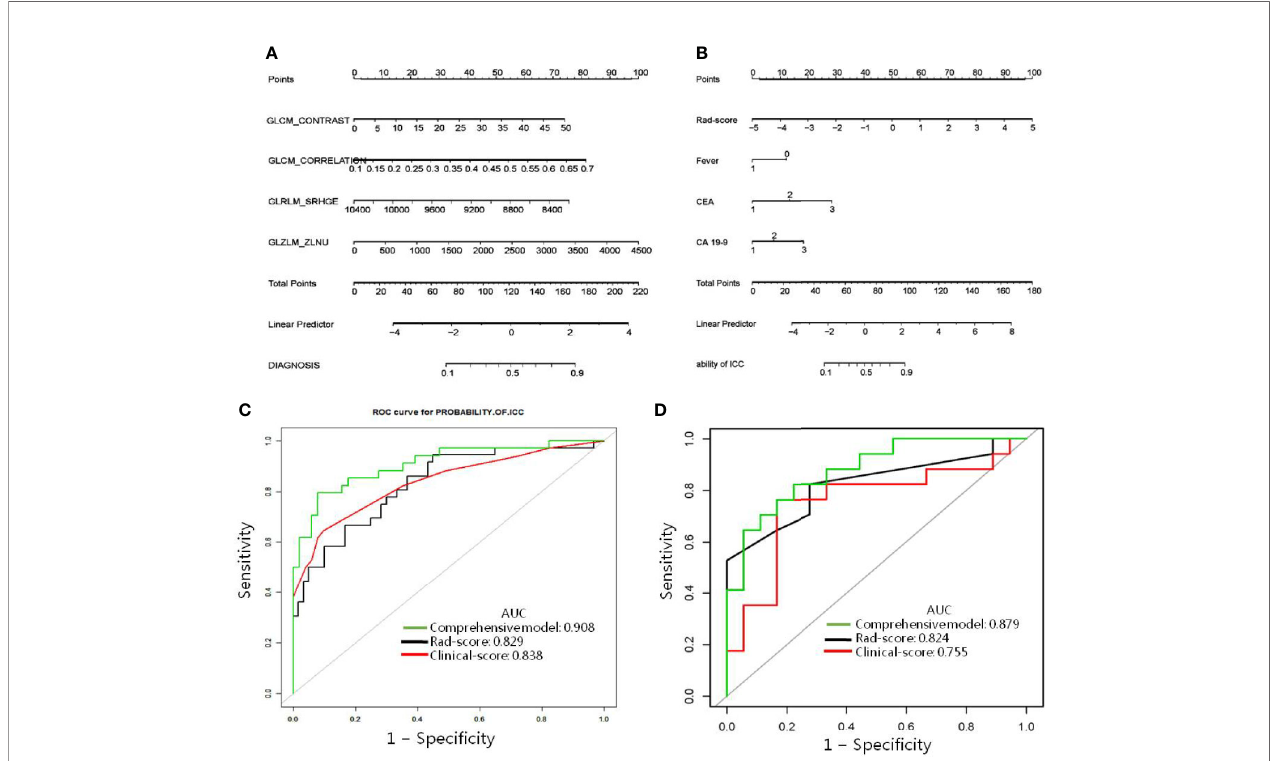
FIGURE 3 | Radiomic nomogram designed with receiver operating characteristic curves. (A) The radiomic nomogram and (B) the comprehensive model was developed in the training cohort for predicting IHL-ICC. Comparison of ROC among the radiomic nomogram, clinical model, and comprehensive model for the prediction of IHL-ICC in the (C) training and (D) validation